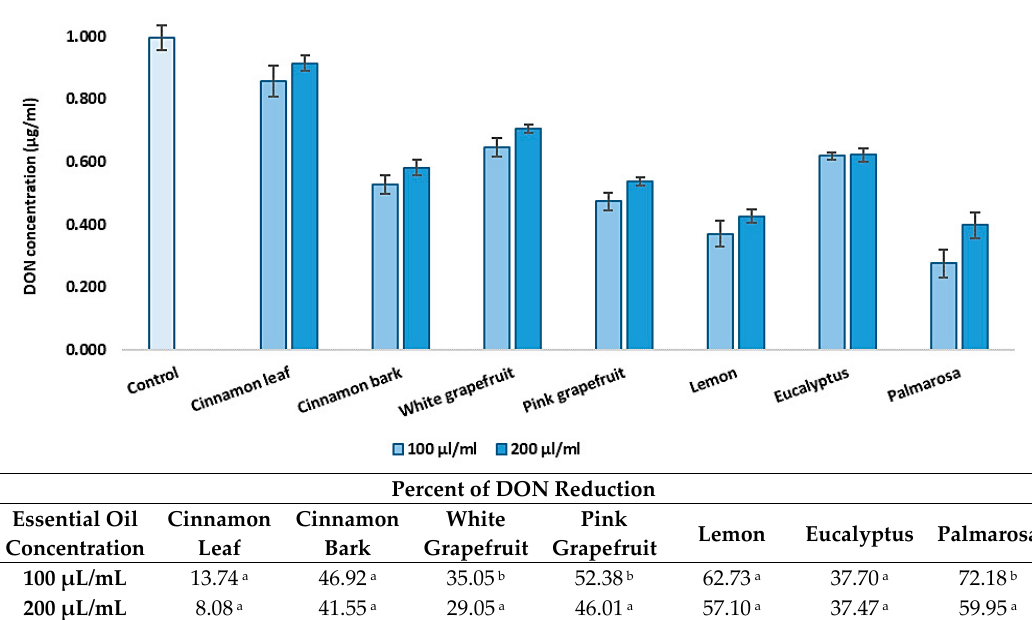
Figure 3. The effect of the essential oils concentration on reduction of deoxynivalenol concentration . The experiment was conducted up to 72 h at 20 ° C. Data were analyzed by Tukey’s test at p < 0.05 ( a , b —significantly different in column). ( a , b —significantly di ff erent in